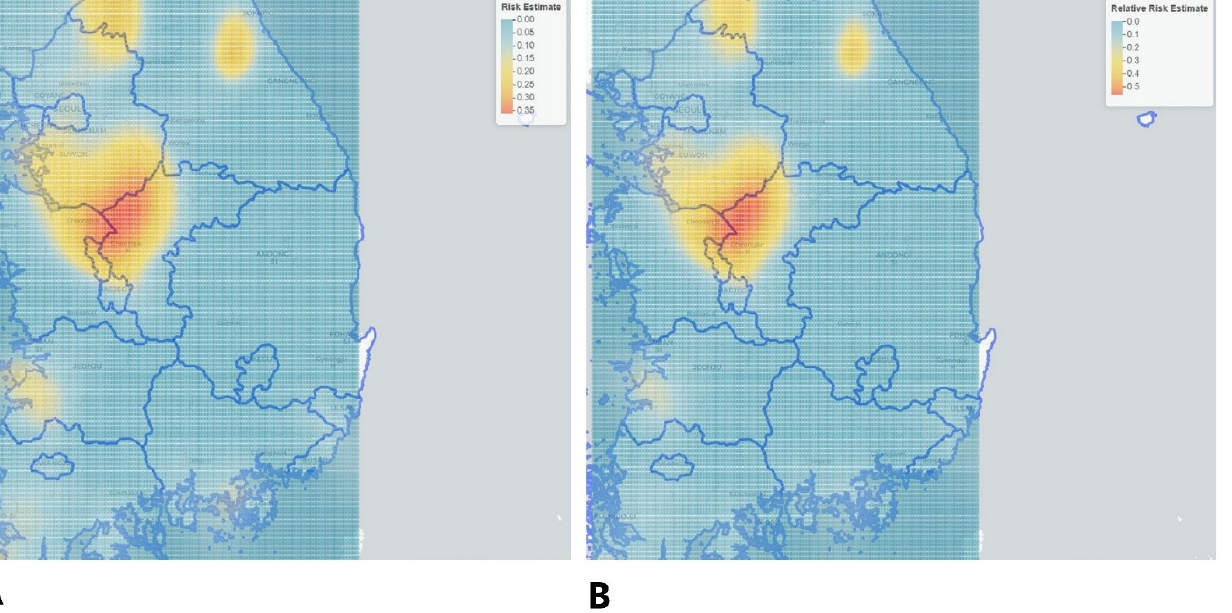
Figure 3. depicts high risk locations on the map of South Korea (Ballatore, Bertolotto, & Wilson, 2013). Kernel density risk estimate ( A ) and relative risk estimate ( B ) of being a case relative to a control. Note: Chungcheongbuk-do, Chungcheongnam-do, Gyeonggi-do, and Jeollabuk-do provinces showed high risk of HPAI H5N6 epidemic.